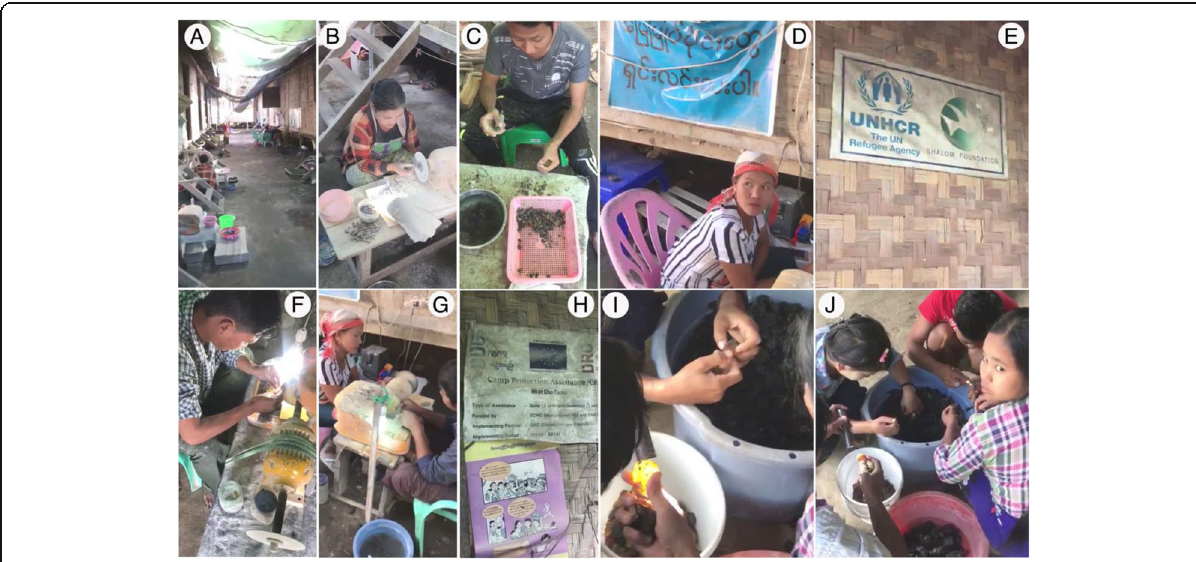
Fig. 2 a – j Example of gemstone cutting operations at internally displaced person (IDP) camp Hkat Cho in 2018. Each house has a cutting facility at its entrance. a Interior view of a camp alley. b – d , f – g Woman and men sorting and cutting amber. d Banner is a protest poster by the IDP camp inhabitants demanding clearing landmines around the amber mines. e United Nations High Commissioner for Refugees banner at camp. h Camp protection assistant, including access to solar energy, camp name Hkat Cho and date of solar installation 2013 – 2014 shows IDP camp pre- dates conflict period of 2017 – 2018. i – j Member of a family working together in the sorting process. Pictures by the authors